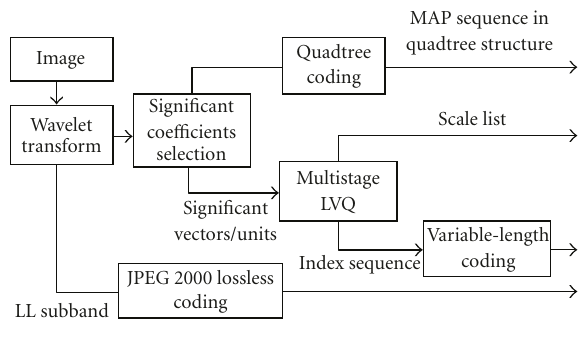
Figure 2: MLVQ encoder